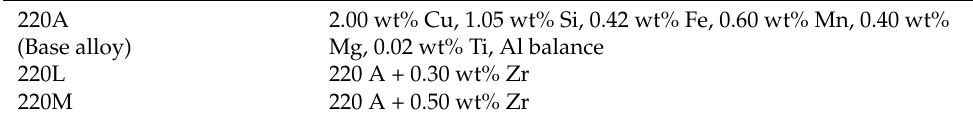
Table 2. Codes and chemical compositions of the Zr group of alloys.